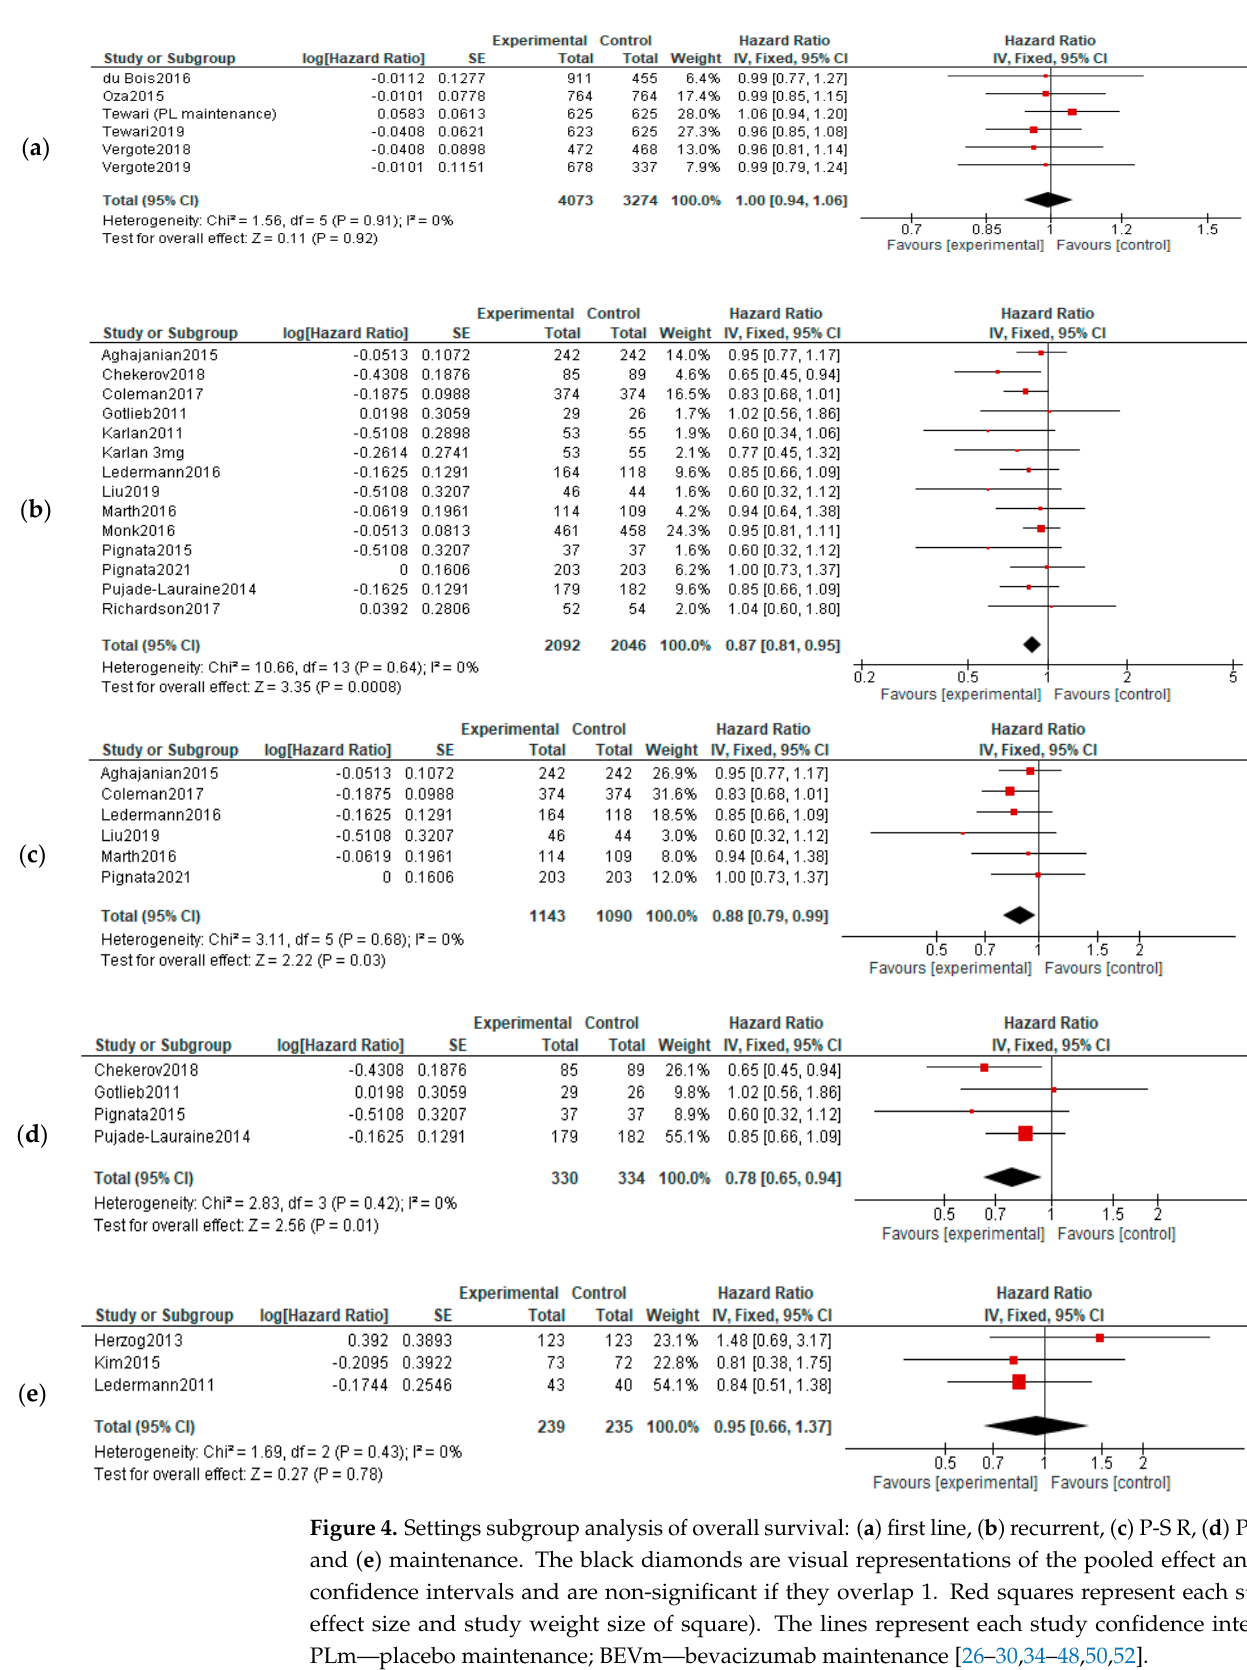
Figure 3. Settings subgroup analysis—time to progression: ( a ) first line, ( b ) recurrent, ( c ) P-S R, ( d ) P-R R and ( e ) maintenance. The black diamonds are visual representations of pooled effect and its confidence intervals and are non-significant if they overlap 1. Red squares represent each study effect size and study weight (size of square). The lines represent each study confidence interval.